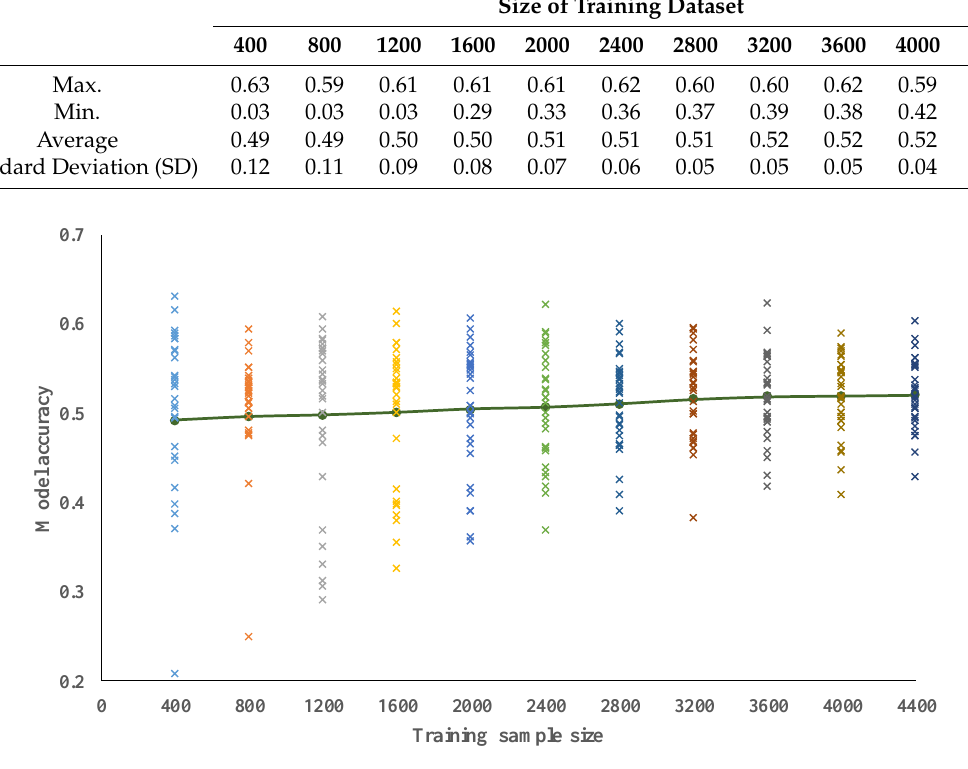
Figure 6. Model accuracy for spectral-yield displacement 𝑆 𝑎𝑦 with 11 building characteristics.